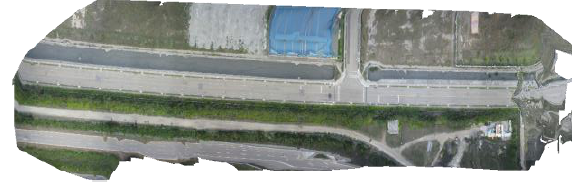
Figure 16 Photo mosaic result